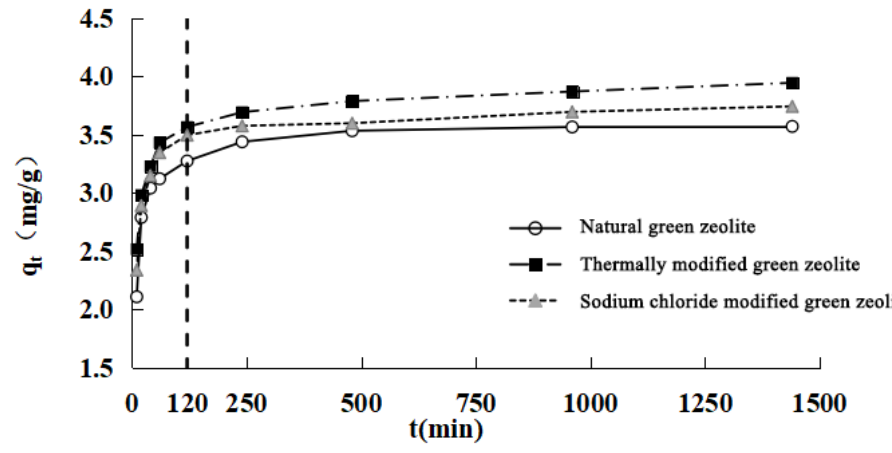
Figure 4. Adsorption kinetics of nitrogen on three kind of zeolites.